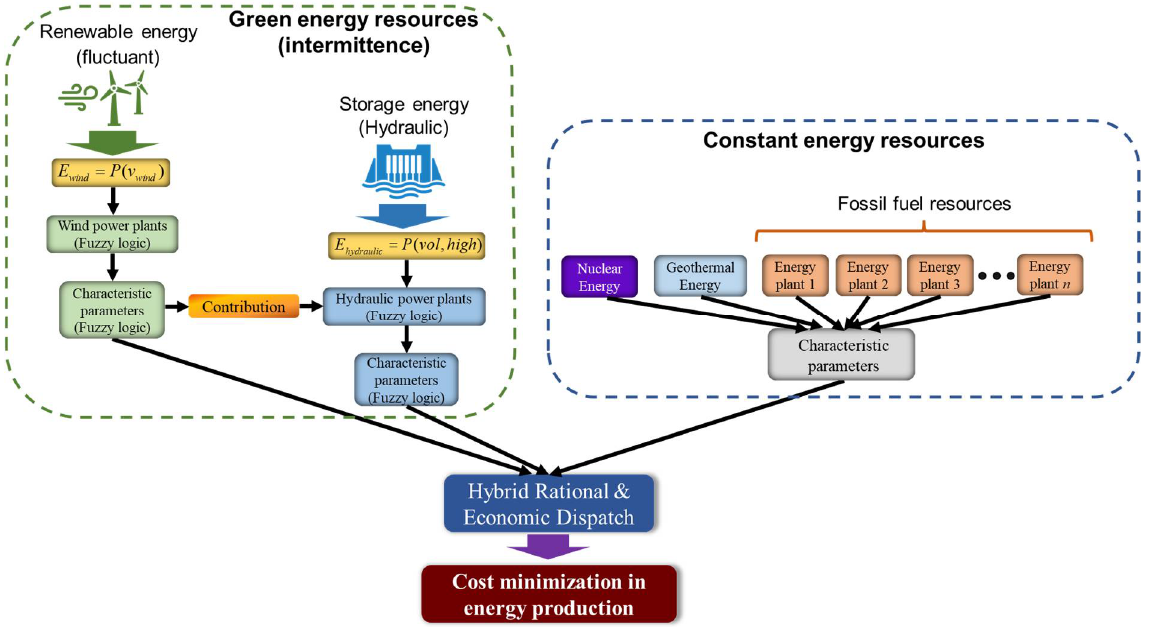
Figure 1. Optimization of a power generation network based on FL and linear system models. The network is composed of plants operating with variable and constant supply sources.